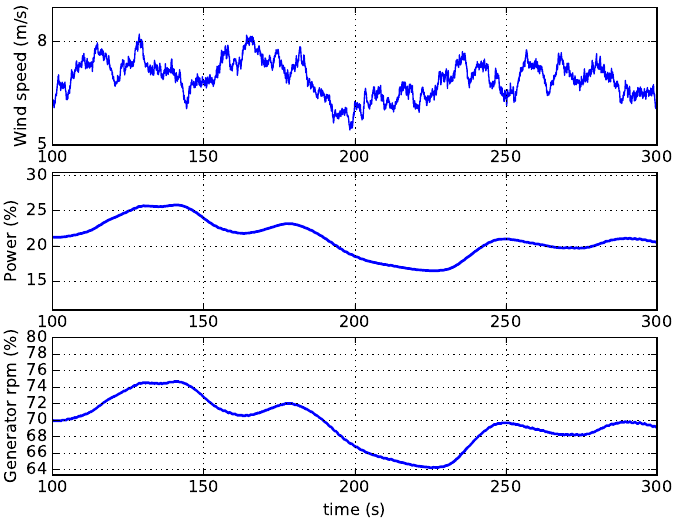
Figure 5. Example of simulated wind, electric power, and rotor rpm time history from FAST (fatigue, aerodynamics, structures, and